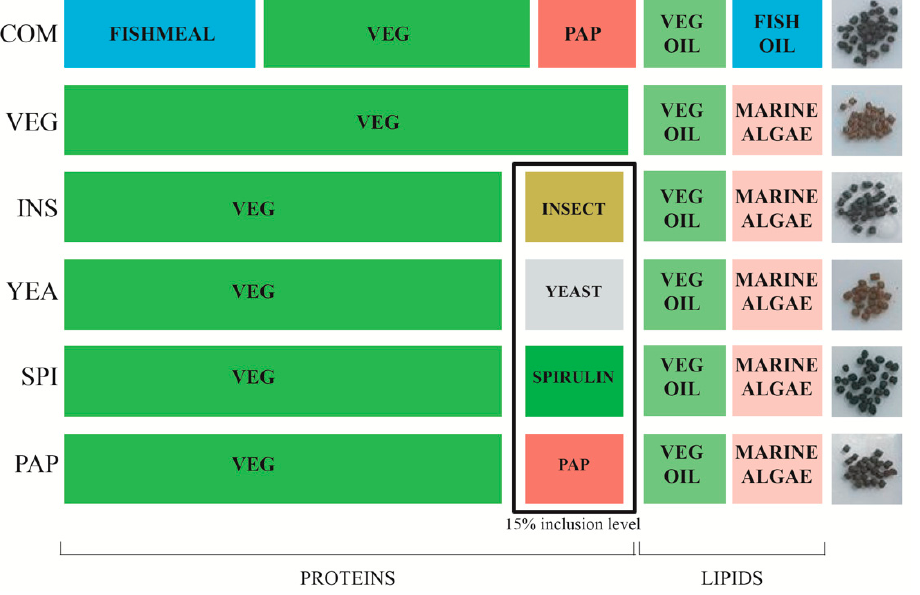
Figure 1. Profiles of fish feed formulations used in this study. The boxed ingredients show the experimental feeds in which 15% VEG feed were replaced by alternative proteins sources. COM: European commercial feed with conventional animal products. VEG: vegetal feed composed exclusively of terrestrial plant products and by-products. PAP: processed animal protein composed of a mix of poultry blood meal and hydrolyzed poultry feathers. INS: hydrolyzed insect meal ( Hermetia illucens ). YEA: yeast Saccharomyces cerevisiae meal. SPI: cyanobacterium ( Arthrospira platensis ). VEG oil: rapeseed oil. All diets, except COM, were enriched with monounsaturated fatty acids (MUFA) oil from marine micro algae ( Schizochytrium sp). The images on the right show the color of experimental